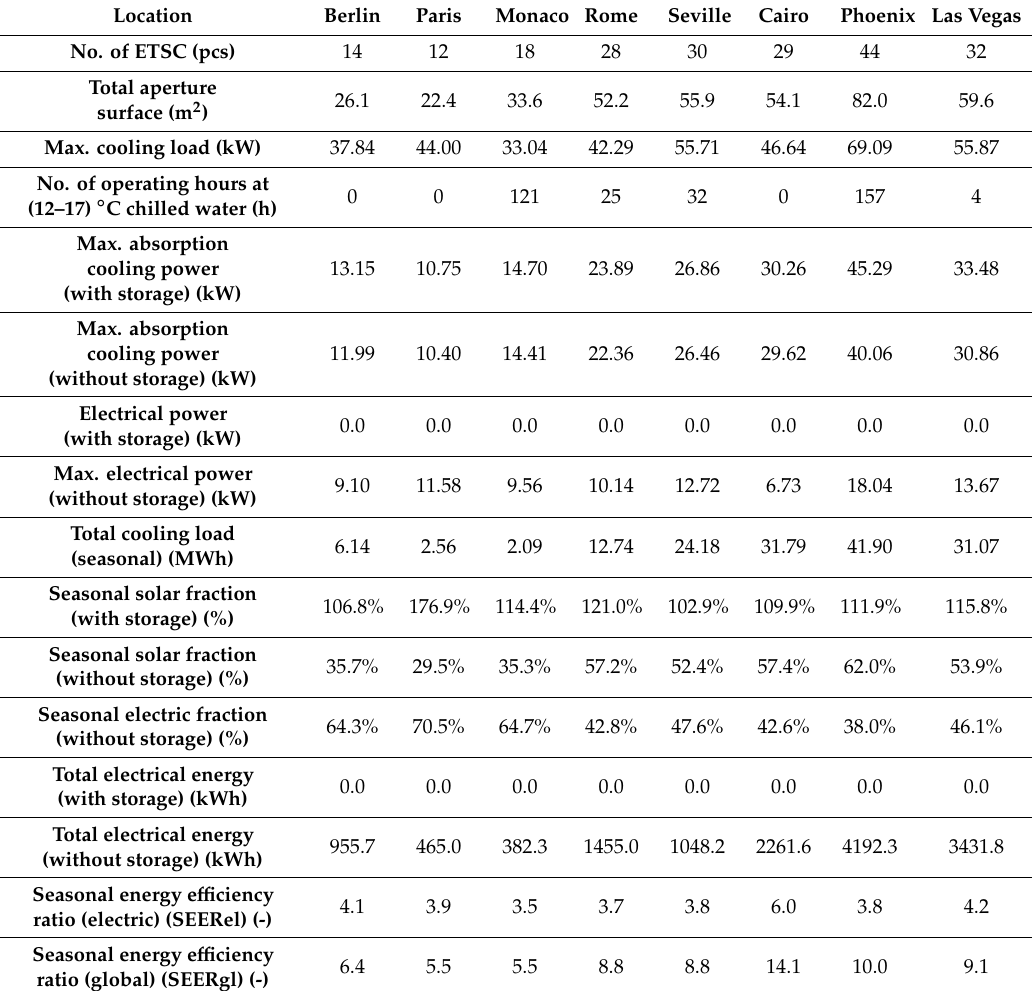
Table 7. Characteristics of the SFACS for each